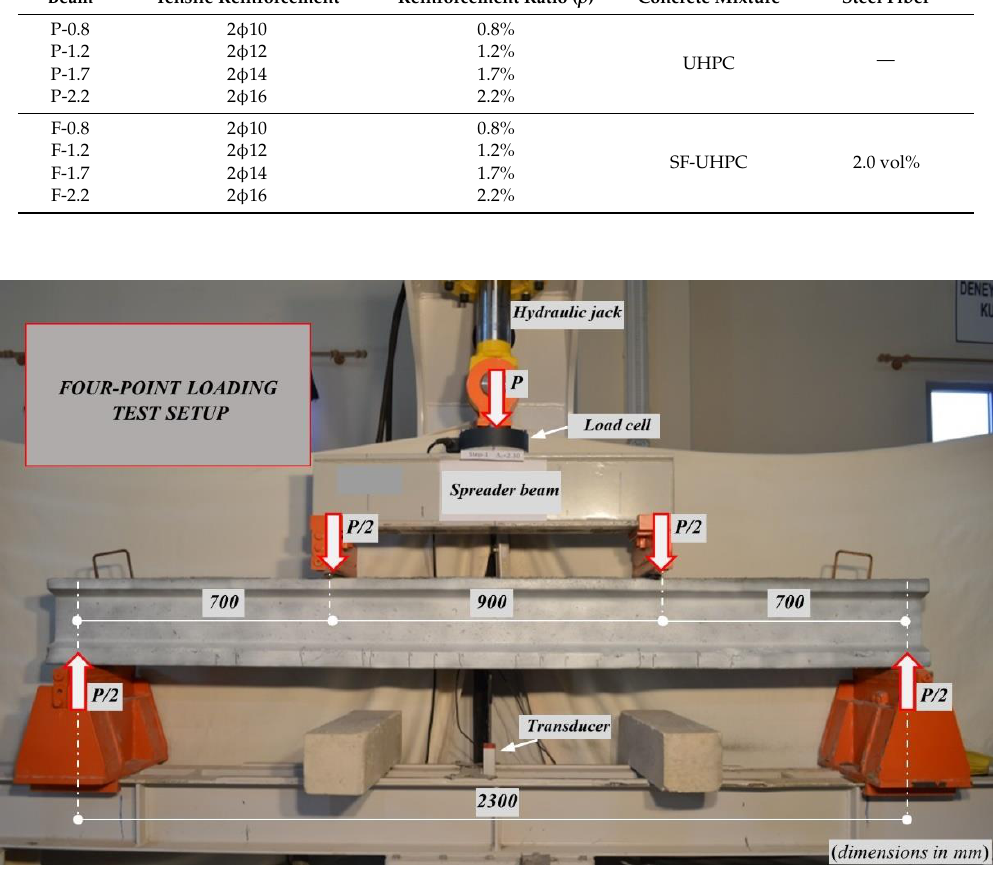
Figure 4. The four-point loading setup.